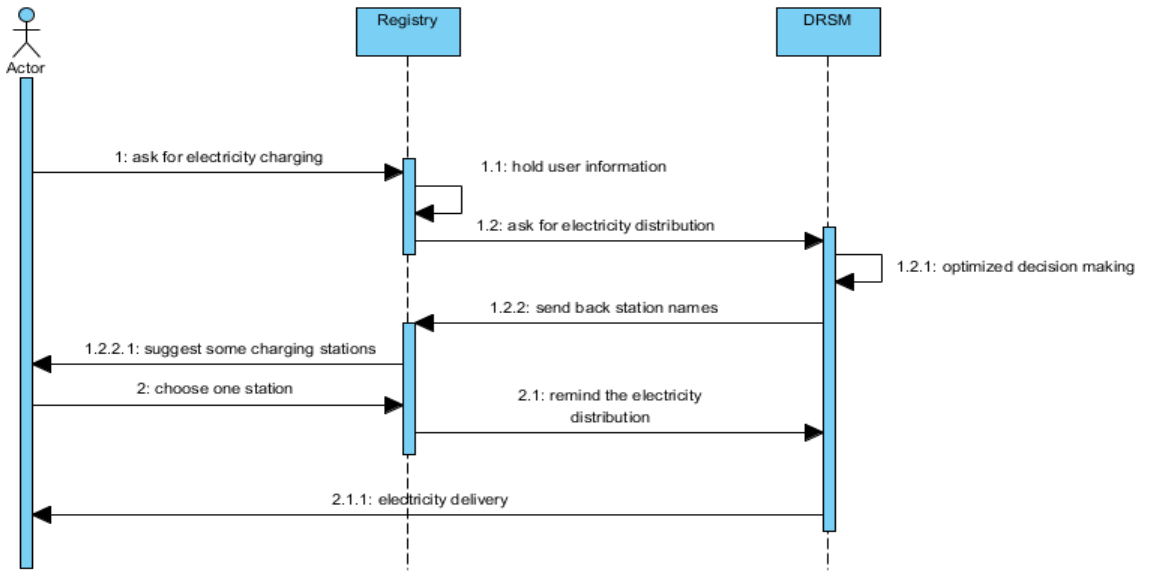
Figure 5. The sequence diagram for web service in the smart grid (SG).